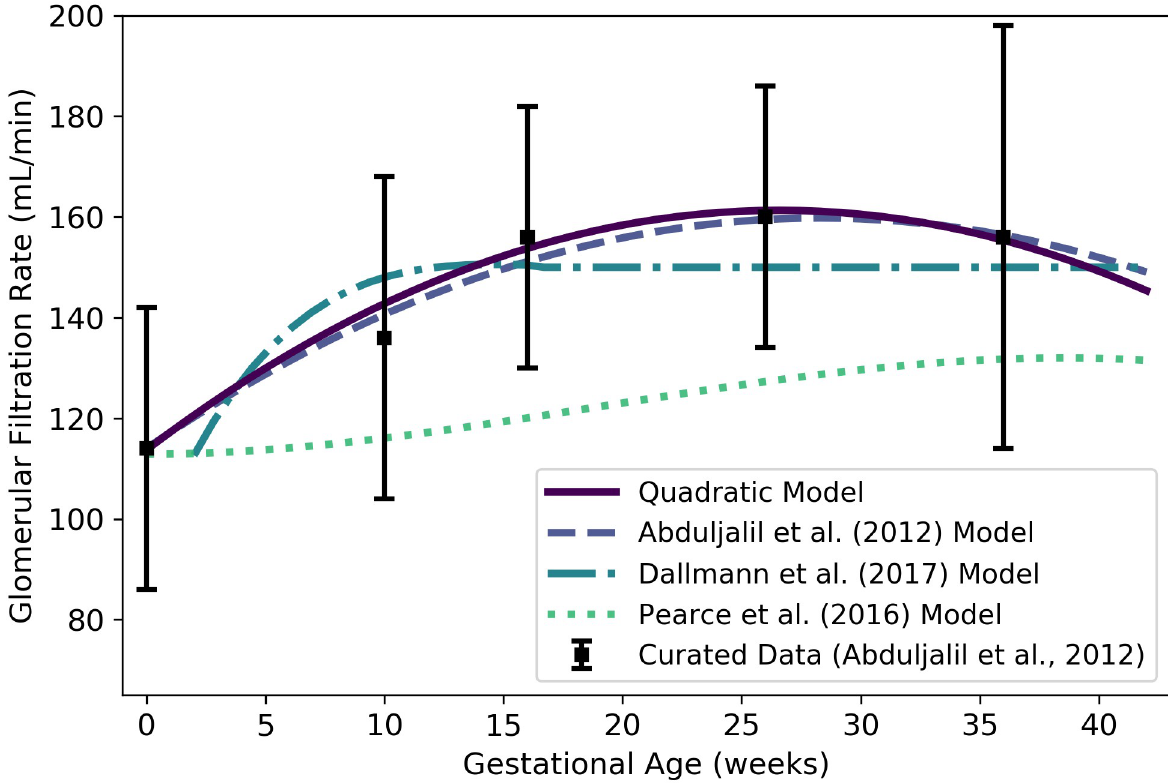
Fig 14. Maternal glomerular filtration rate vs. gestational age. The quadratic model (solid line) given by Eq 26 was selected as the most parsimonious model in our analysis. The model of Abduljalil et al. [28], also a quadratic model, was calibrated using the same curated data set [28] used by us. The Dallmann et al. [3] model depicted here has been modified from the published version, which contained typographical errors, based on personal correspondence with the lead author. The model attributed to Pearce et al. [61] is evaluated as described in the text.